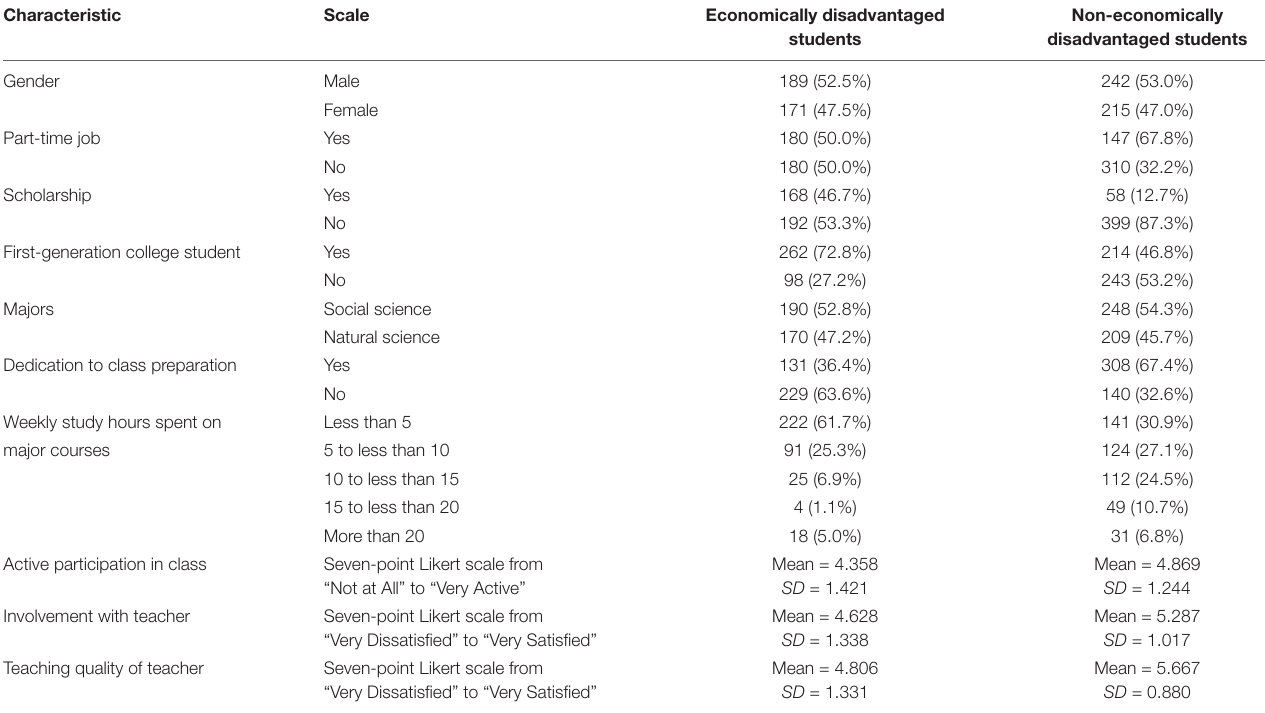
TABLE 1 | Descriptive statistics by socioeconomic status and measurement scales.